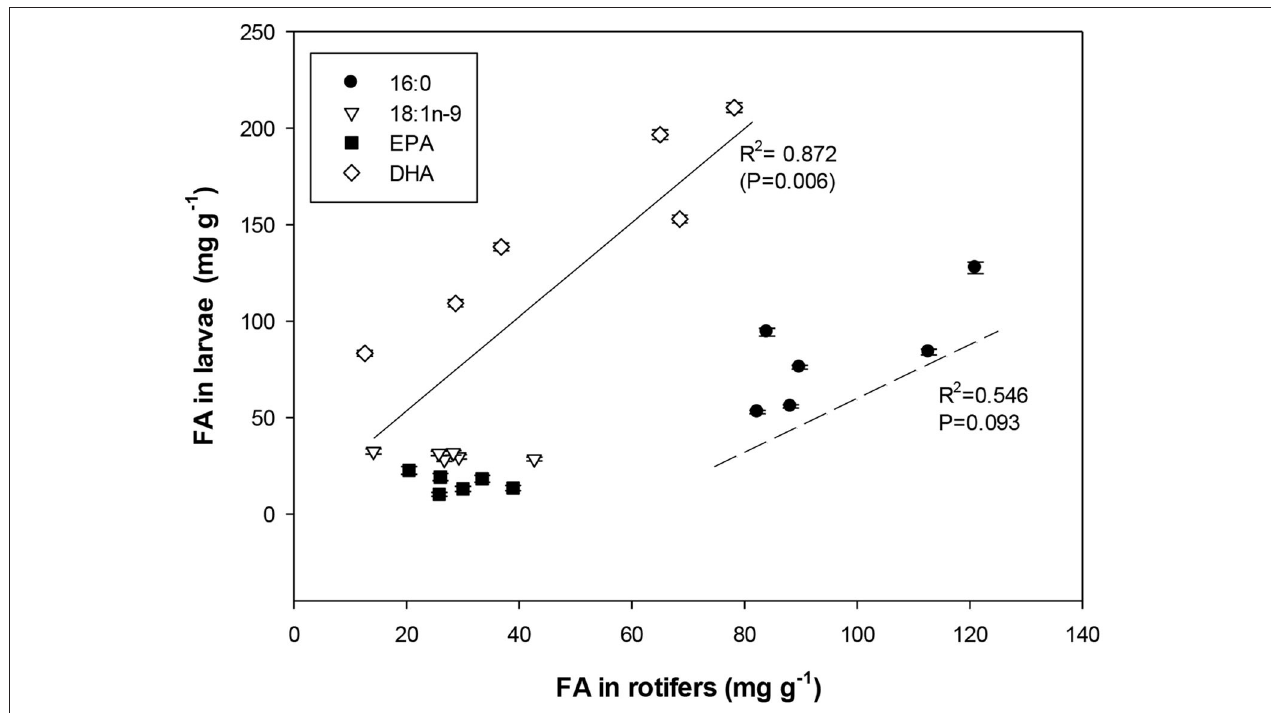
FIGURE 2 | Linear regressions found between the most important fatty acids in PL in 15 dph meager larvae as a function of the respective fatty acid composition in the PL of enriched